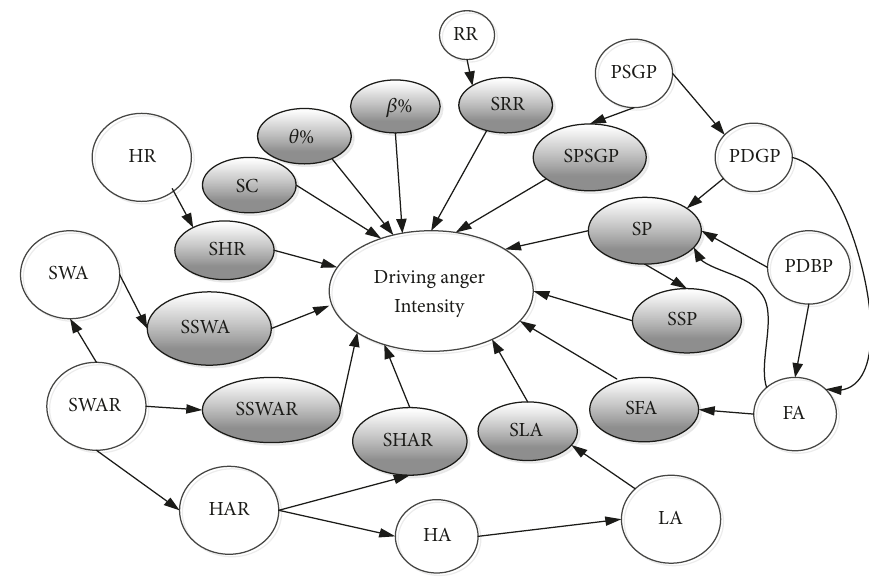
Figure 6: The Markov blanket of driving risk status. Table 4: The correlation test for features based on IAMB